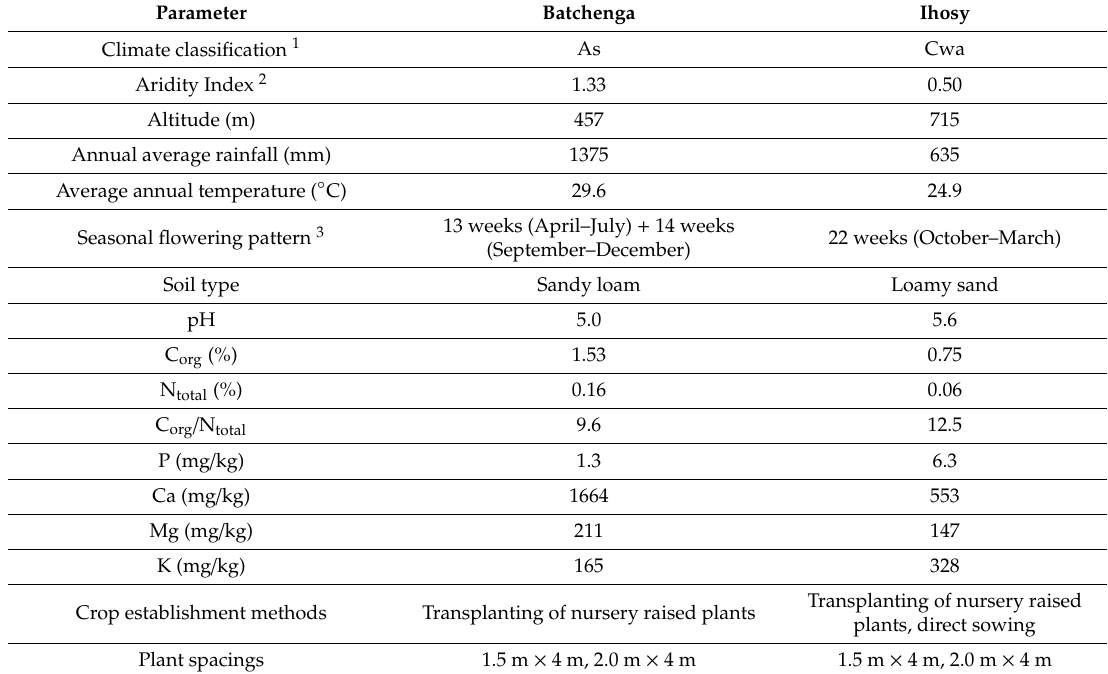
Table 1. Characterization of the locations and field